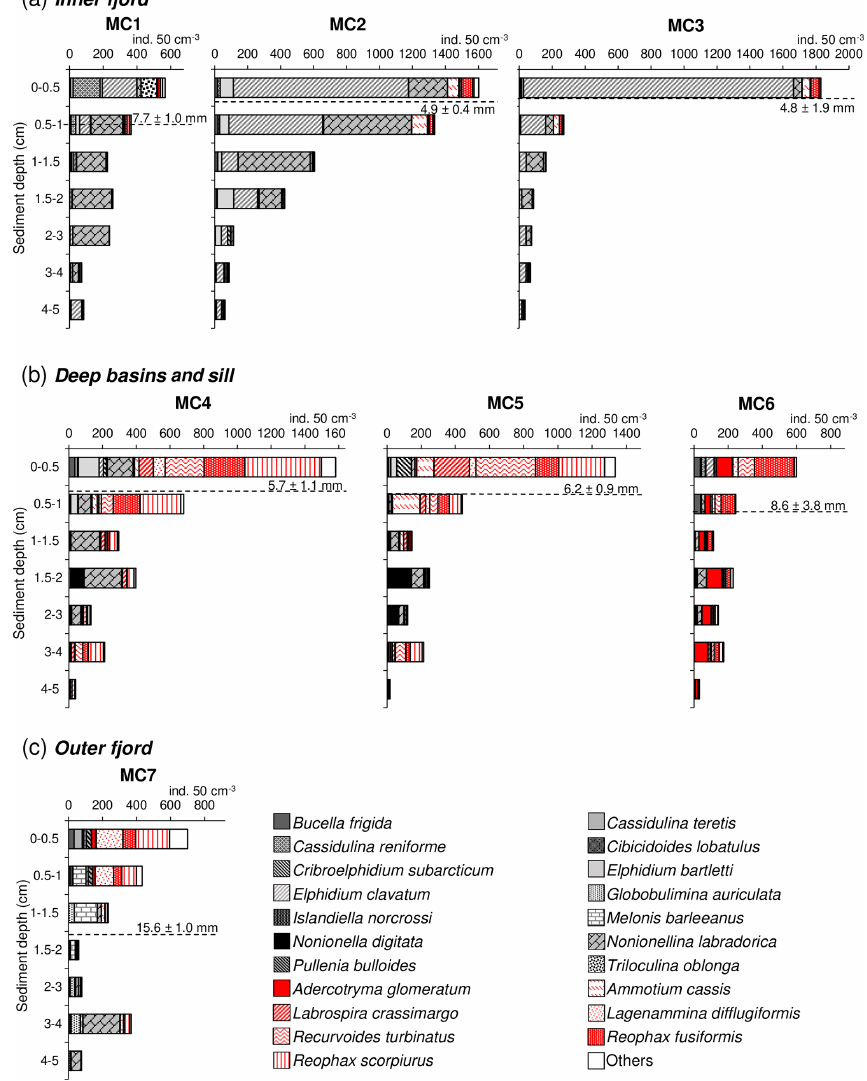
Figure 4. Foraminiferal vertical distribution from 0 to 5cm sediment depth ( > 150µm fraction) for (a) the inner fjord (stations MC1 to MC3) (b) deep basins (stations MC4 and MC5) and sill (station MC6), and (c) outer fjord (station MC7). Calcareous species are shown using different grey textures, whereas agglutinated species are shown using different red textures. The dashed black line represents the average oxygen penetration depth (OPD) at each